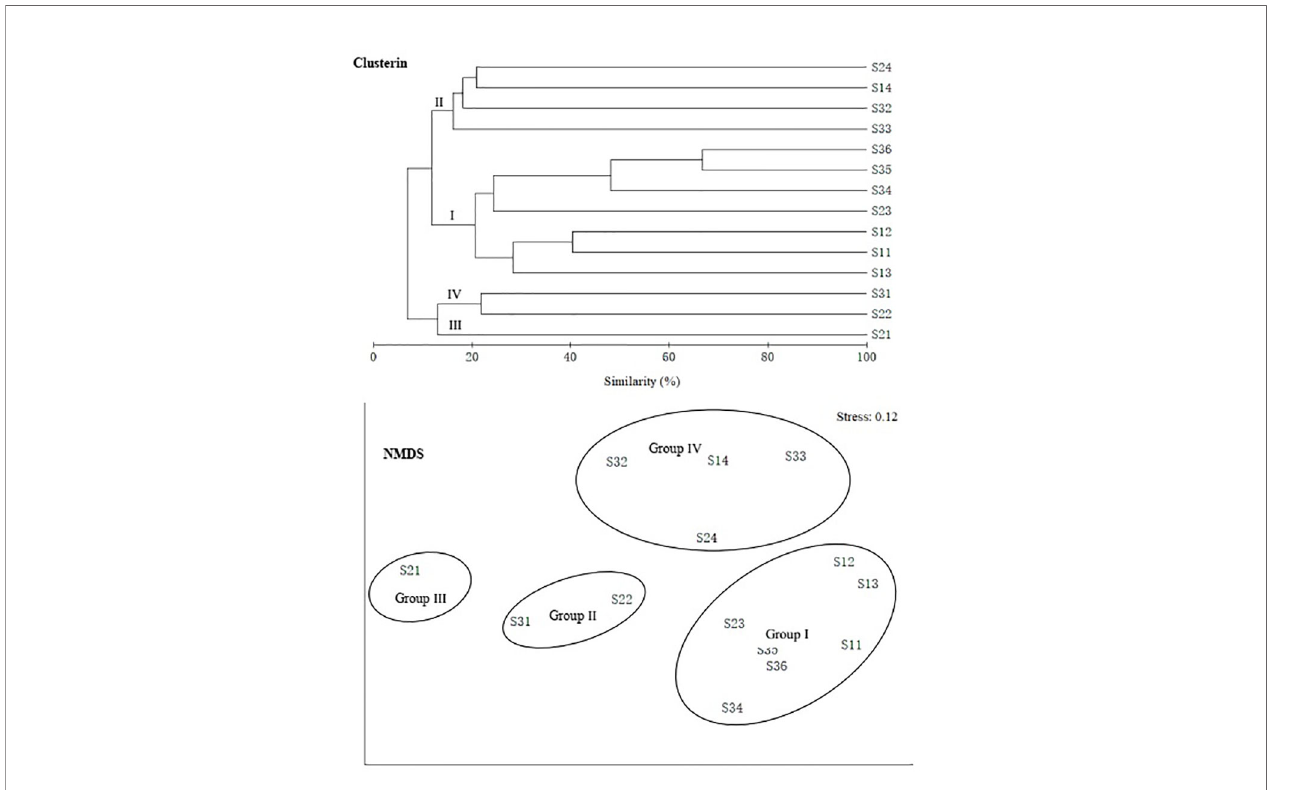
FIGURE 7 | Group average clustering and non-metric multi-dimensional scaling (NMDS) among genus of demersal fi sh over the NCSSCS.